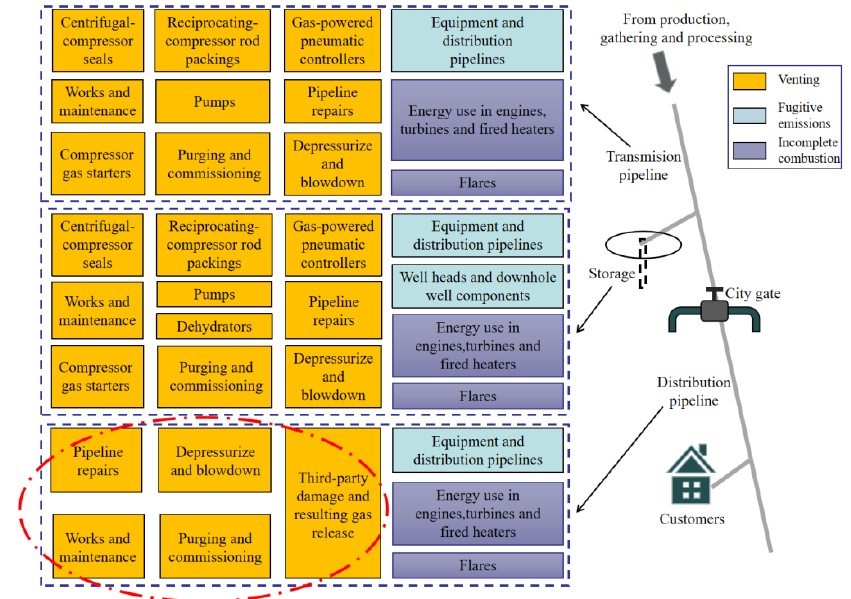
Figure 1. Methane emissions from natural gas supply